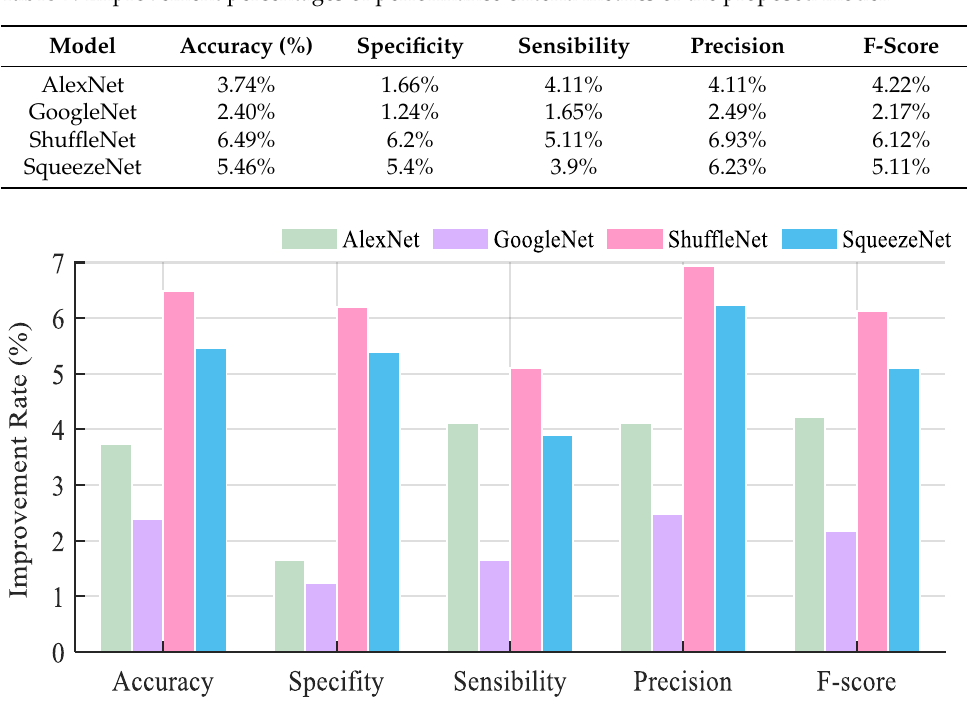
Figure 8. Improvement rate (%) of the proposed model in performance criteria.